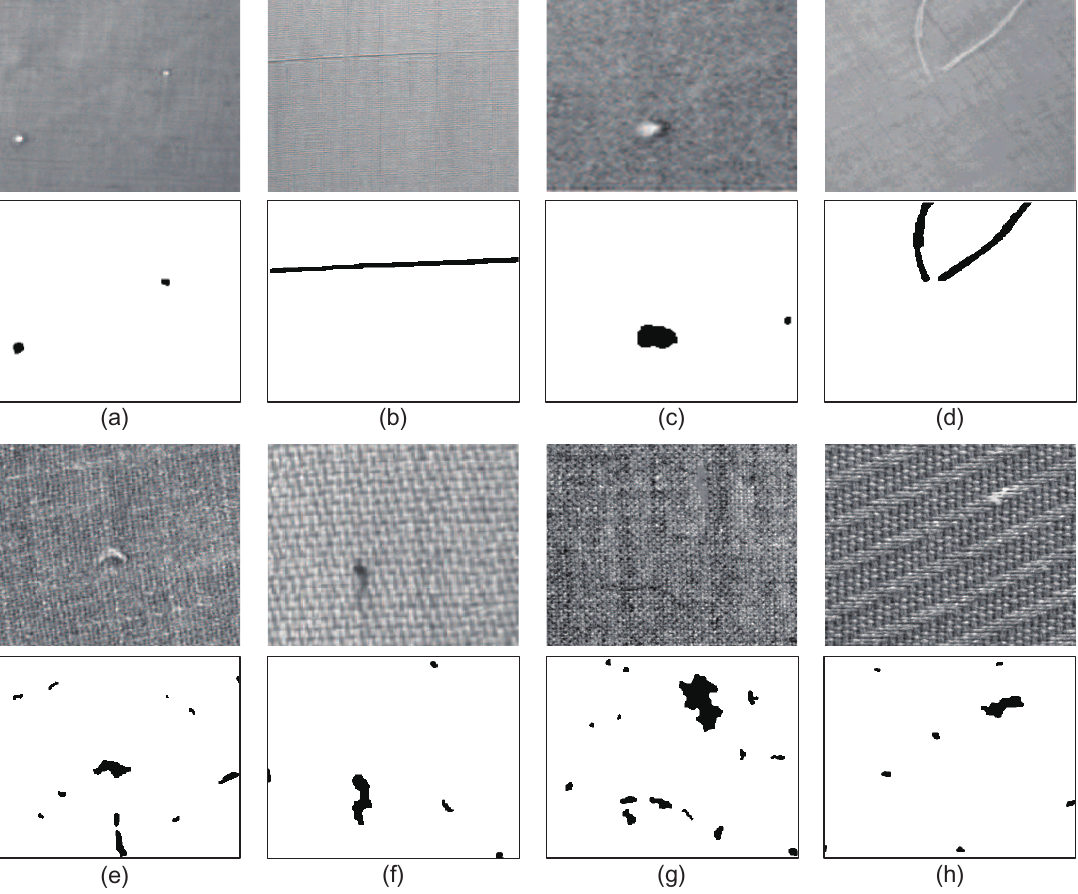
Figure 10. Defect inspection results using the proposed MSCDAE model. The images ( a )–( d ) and ( e )–( h ) belong to the p 1 and non- p 1 types of defects, and they are representative samples in each sample